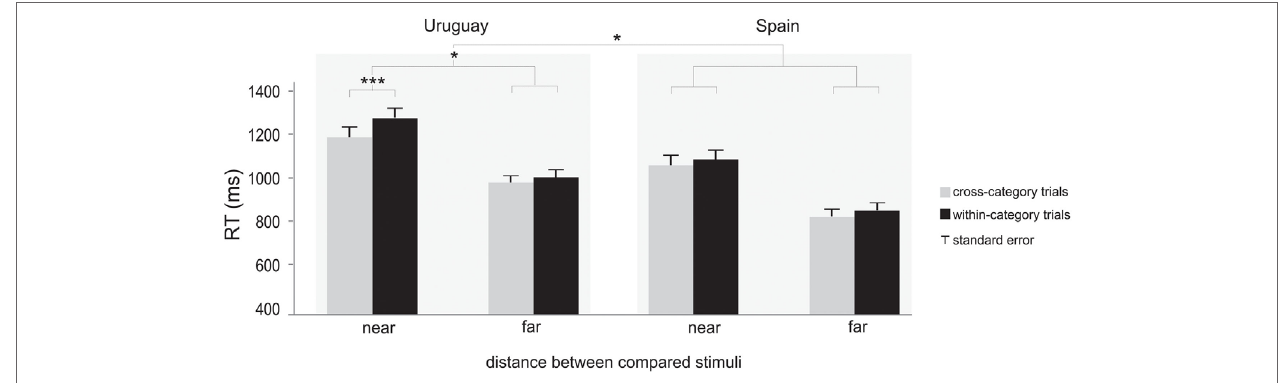
FigUre 6 | Mean response times (ms) between cross- and within-category stimuli by country and distance. Error bars represent